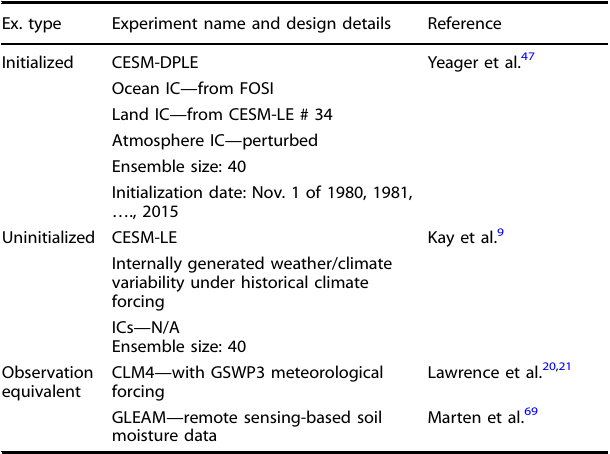
Fig. 1 Skillful prediction of the 2012 soil moisture drought in the California – Nevada region (30° – 37° north latitudes and 110° – 120° west longitudes). The CESM-DPLE drought forecast, initialized in November 2011, and the uninitialized CESM-LE forecast are compared with two observation equivalent data (CLM and GLEAM). The thin lines show anomalies from individual ensemble members, and the thick lines show ensemble mean. Table 1. List of climate experiments employed to investigate S2D hydroclimate